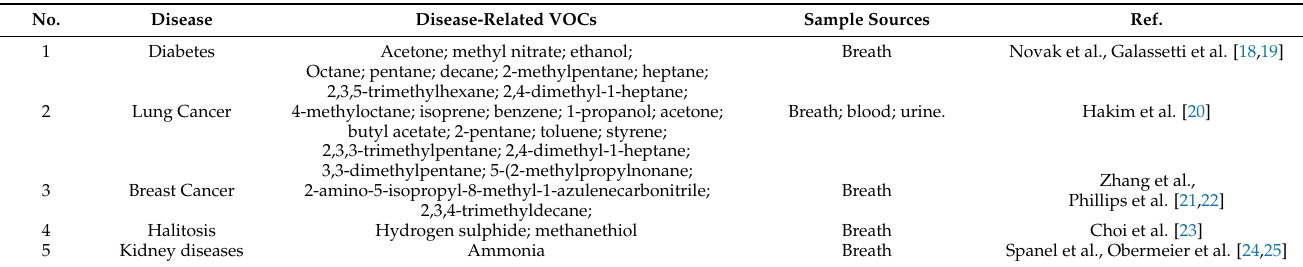
Table 1. Summary of main VOCs from selected non-communicable diseases. Disease-Related VOCs Sample Sources